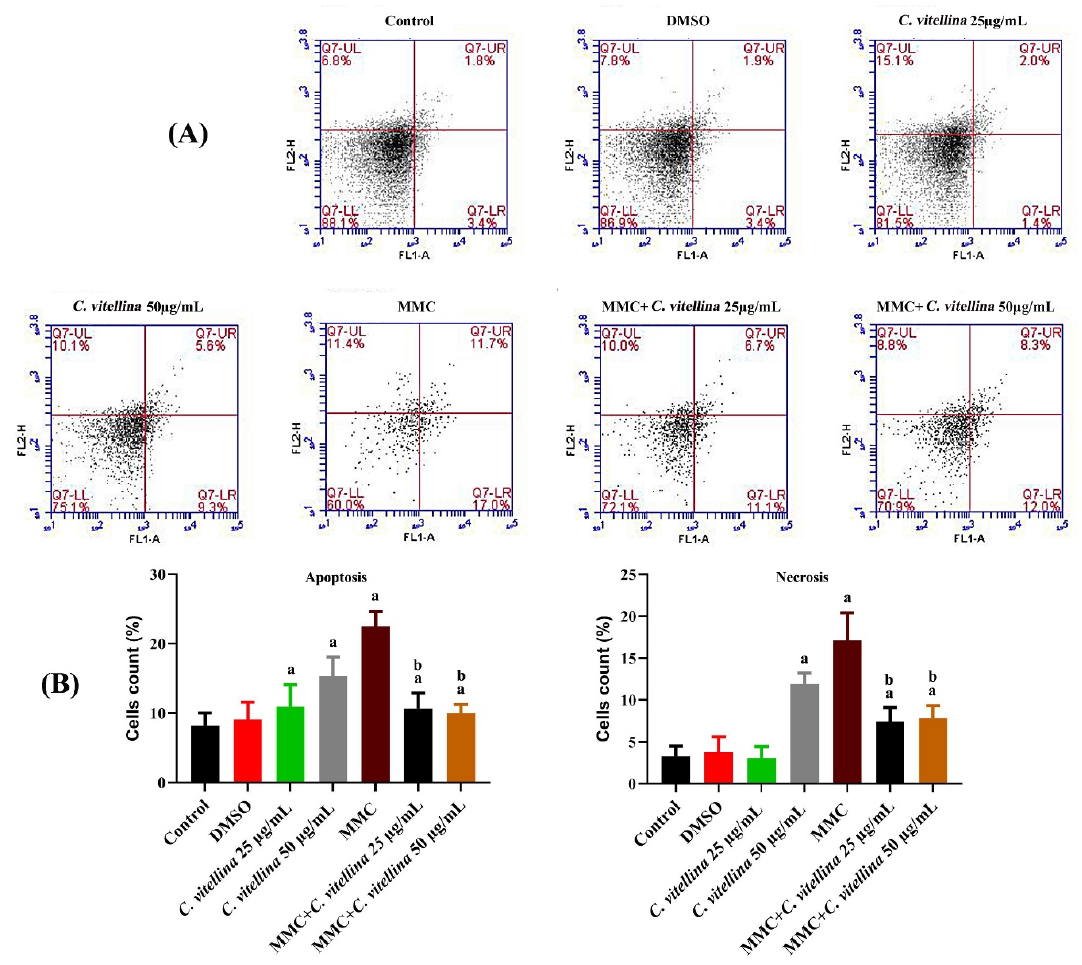
Figure 3. Representative histograms showing the ameliorative effect of C. vitellina extract on HPBL, 24 h against MMC toxicity, using Annexin V-FITC / PI assay showing the apoptotic stages and necrosis ( A ). The percentages of cells' distribution of apoptosis and necrosis are illustrated in the histograms. ( B ). Results show the significant differences at ( p ≤ 0.05) in co-treated groups with respect to untreated (a) and MMC-treated (b) groups. Data were represented as (Mean ± SD) of three different experiments (n = 3). MMC: Mitomycin C (0.5 µg/mL).